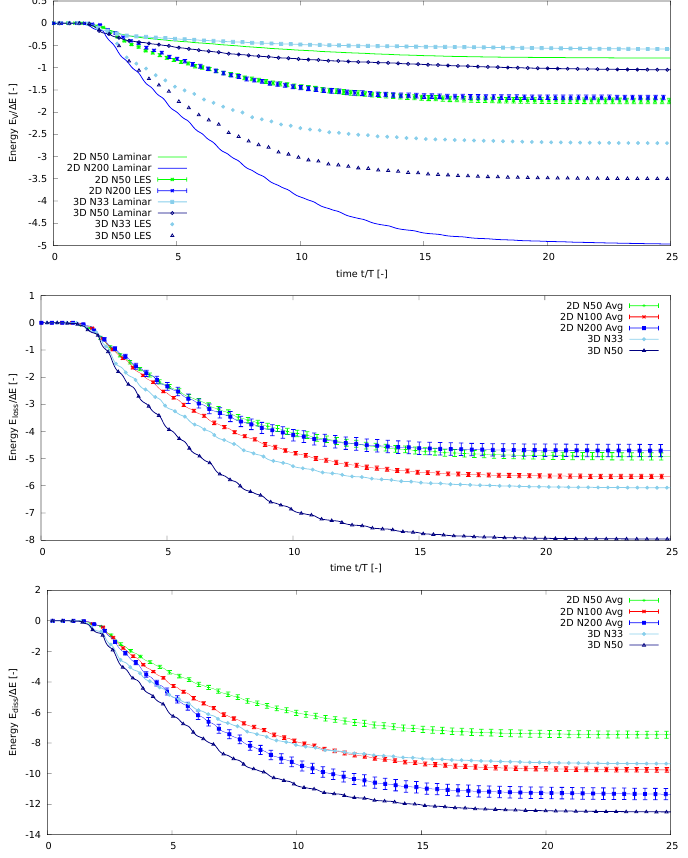
Figure 29. Comparison of energy viscous dissipation ( top ), impact losses ( middle ) and total dissipa- tion ( bottom ) for